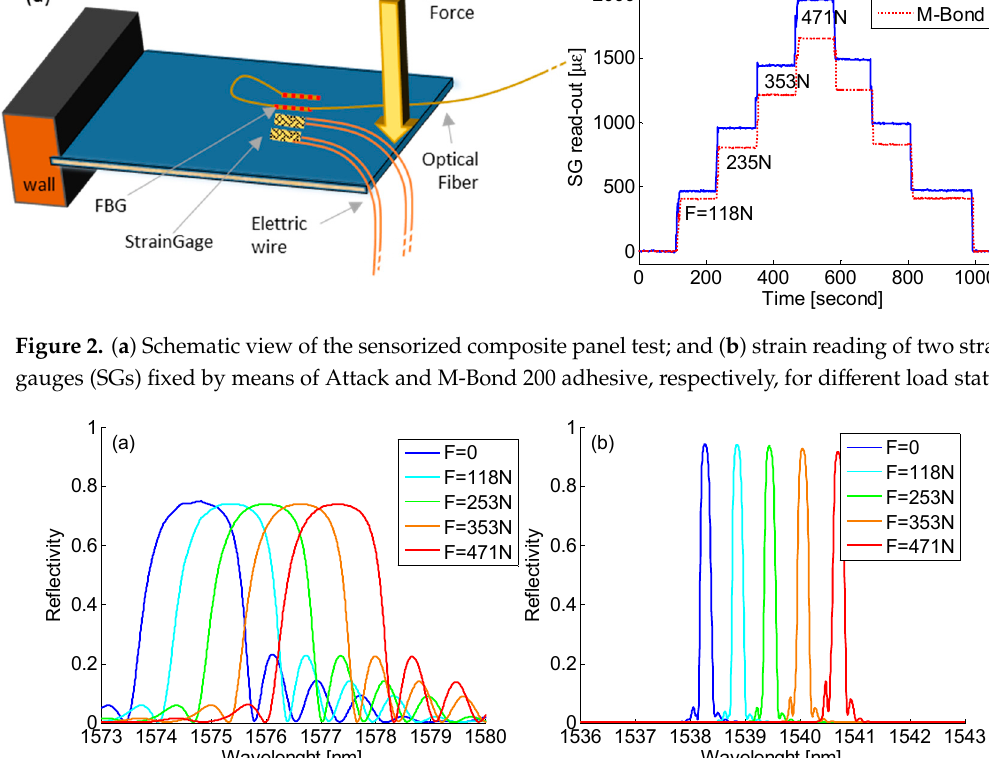
Figure 3. Fiber Bragg Grating ( FBG) spectra in different strain states: ( a ) a 1.0 mm long FBG; and ( b ) a 10.0 mm long FBG.